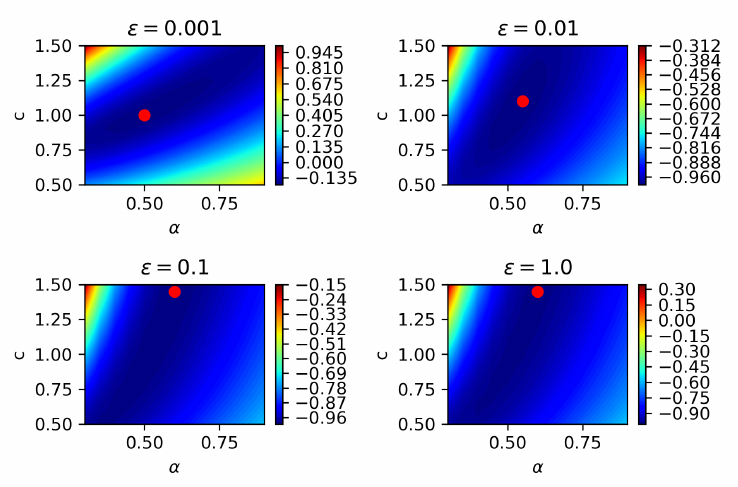
Figure 10. Two-parameter estimation for a partial observation: Contour plots of normalized negative log-likelihood for pairs of ( α , c ) ∈ [ 0.3,0.9 ] × [ 0.5,1.5 ] . The effect of noise magnitude on the estimated parameters is demonstrated. The true values for α and c are α ∗ = 0.5 and c ∗ = 1.0. The plots for different noise magnitudes are compared. For all plots, the controlling parameters for partial observation are fixed to r x = 16 and r t = 8. The red disk represents the optimal parameter pair that minimizes the negative